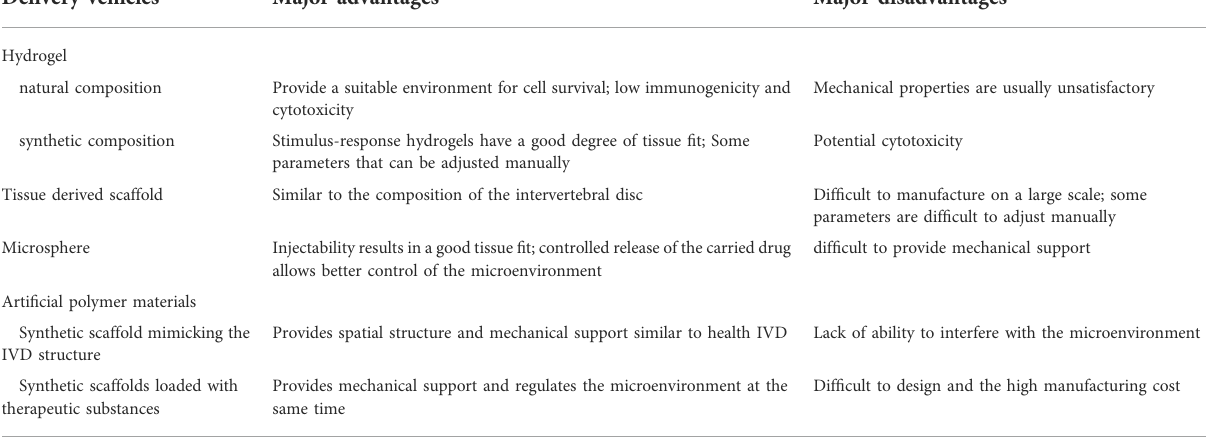
TABLE 2 A brief comparison of different biomaterials used to deliver stem